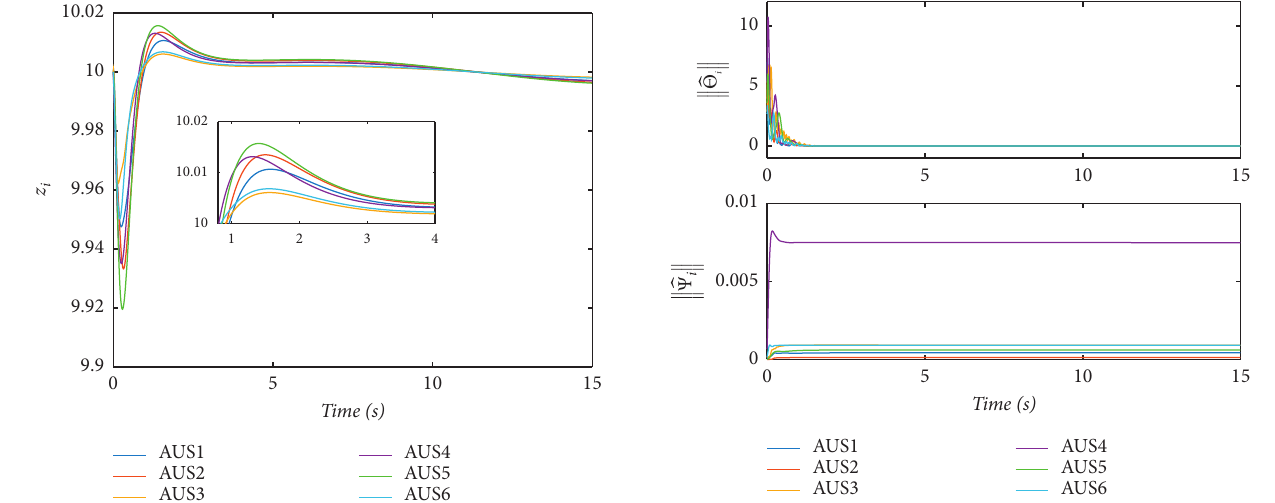
Figure 5: Trajectories of z position of CAUS. Figure 7: Trajectories of the adaptive parameters of CAUSs.